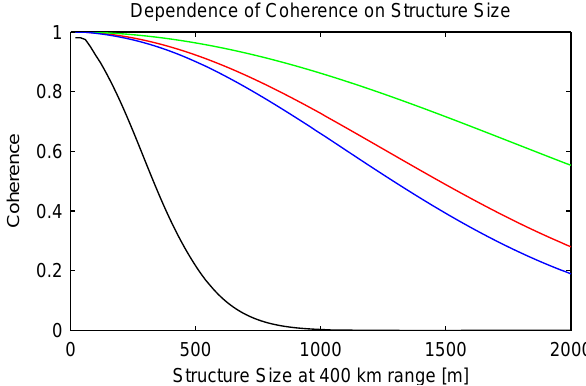
Figure 2. Dependence of coherence on the scale size of a scattering region with Gaussian cross section for the four baselines. Colors are the same as in Fig. 1. Note that the cut-off at 100m in the coherence of 32m/42m baseline is due to the resolution of the model point